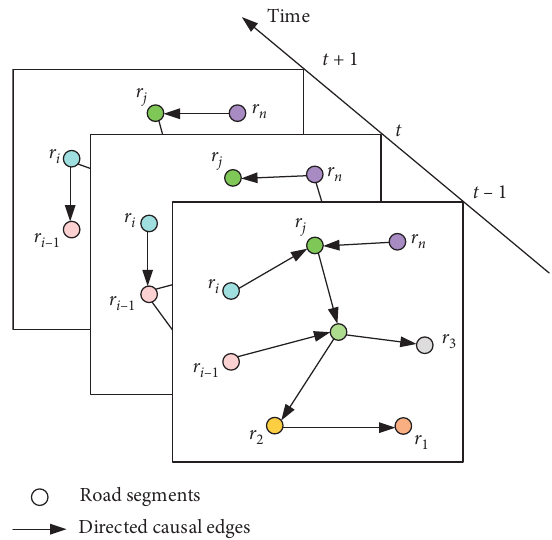
Figure 3: Dynamic spatiotemporal traffic causality graphs.